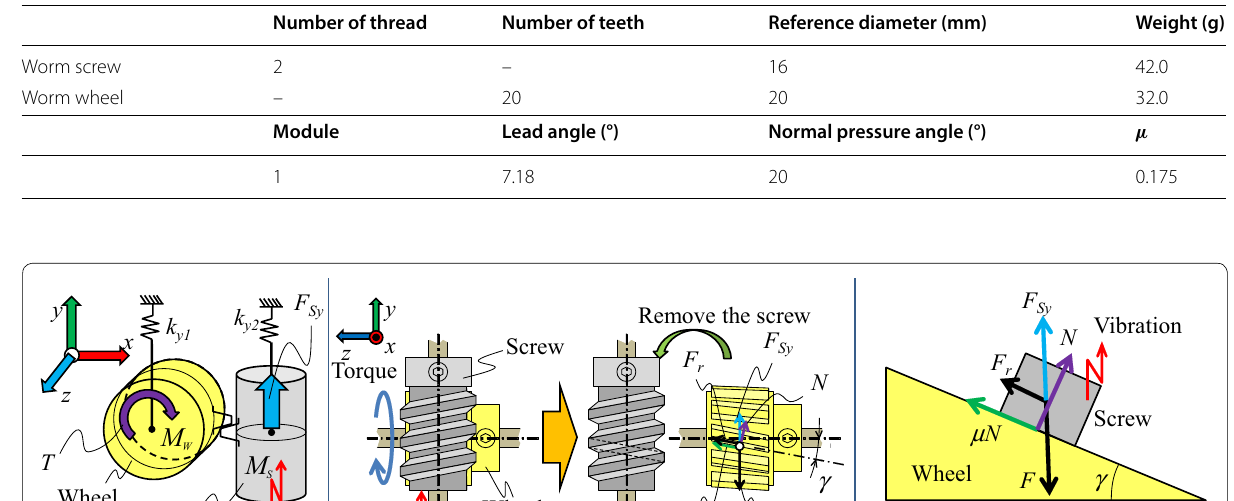
(a) Vibration diagram (b) Details of the forces acting at the contact of the worm gear point of the worm wheel and the worm screw. Fig. 3 Vibration to the screw-axis